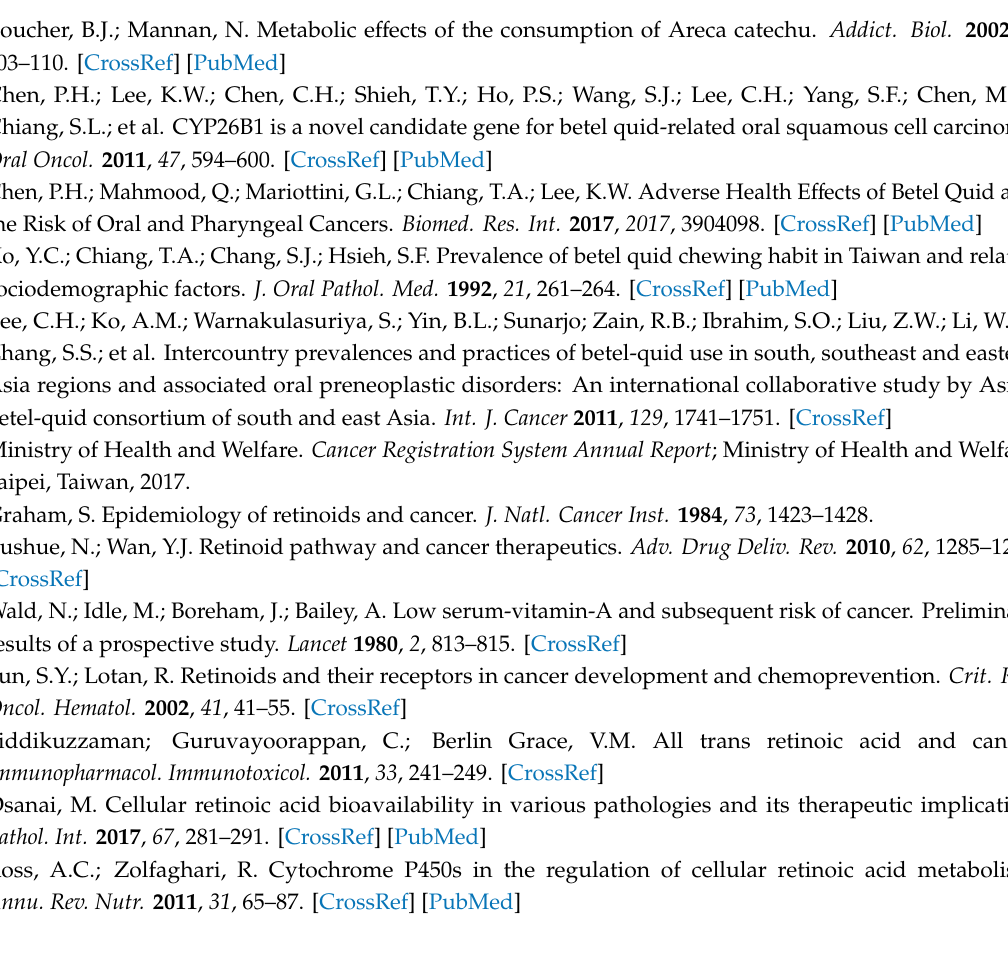
Figure S1: Expression of CYP26A1 between oral and pharyngeal cancer sites. Figure S2: The levels of CYP26A1 mRNA expression in the Di ff erent genotypes of rs2068888 (n = 18). Figure S3: The hypothesis for BQ dependent pathogenic e ff ect of CYP26A1 on the occurrence of oral and pharyngeal cancers. Table S1: Distribution of oral and pharyngeal cancer patients (n = 37) associated with characteristics of selected demographic factors, substance use habits, and clinical